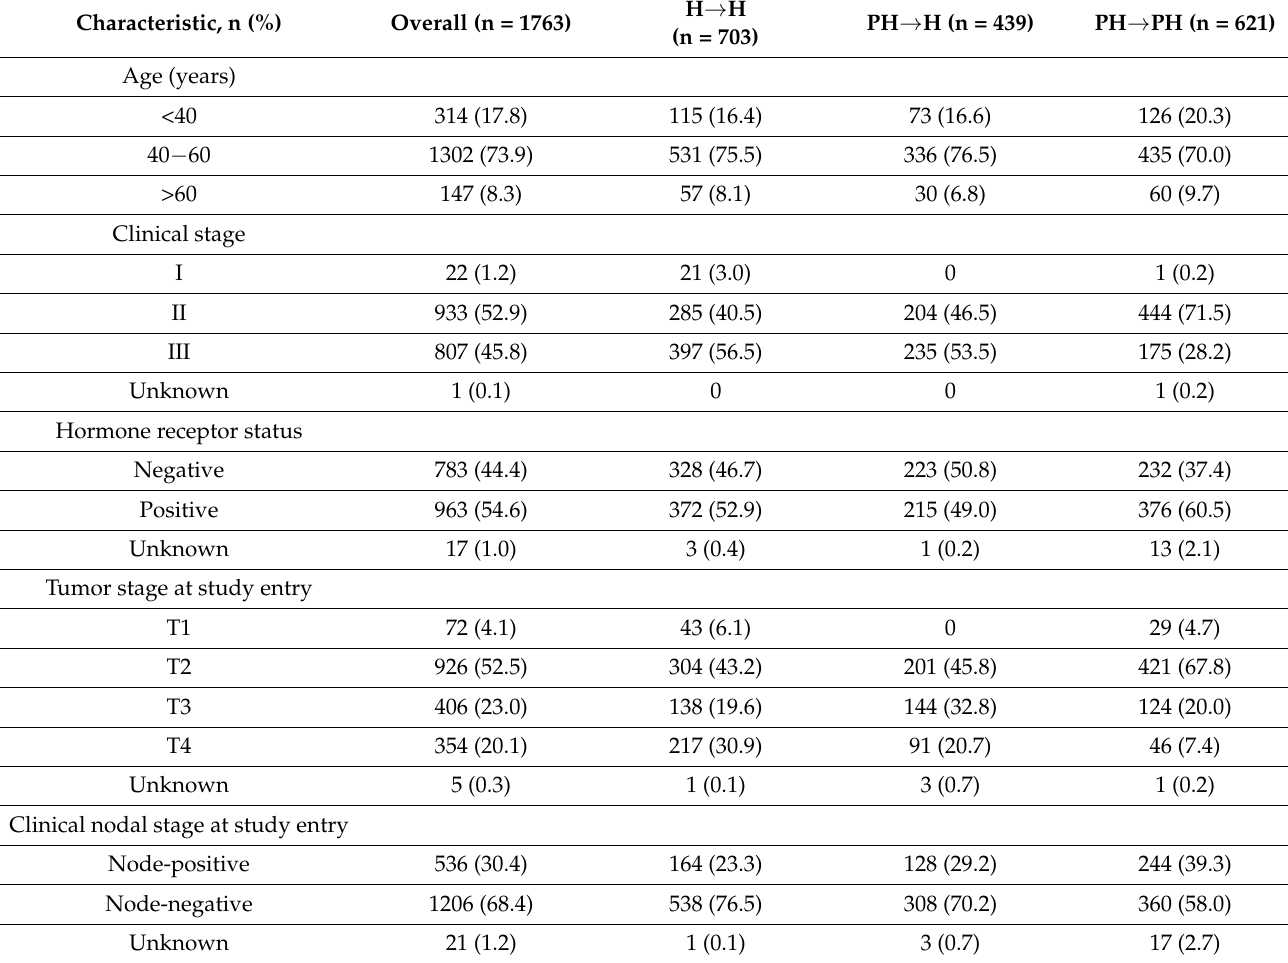
Table 1. Baseline characteristics.